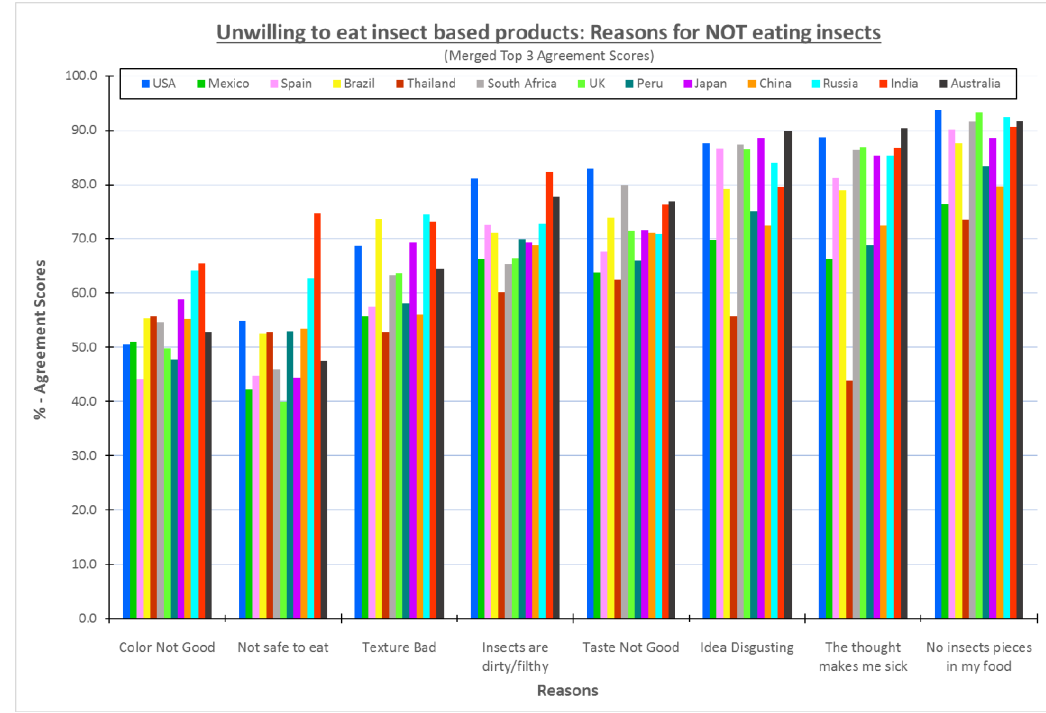
Figure 1. Graph of the reasons for not eating insect based products—Consumers unwilling to try.